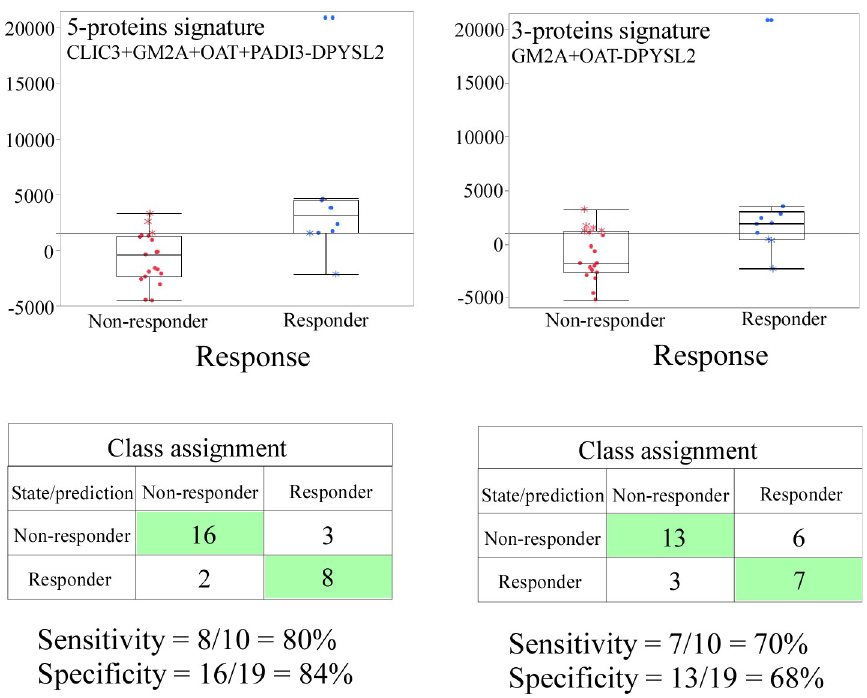
Fig 2. Box plot representations and performance of the 5- and 3-protein signatures predictive for lumretuzumab activity in responder and non-responder FFPE xenograft models. The box plots data distribution includes minimum, first quartile, median, third quartile, and